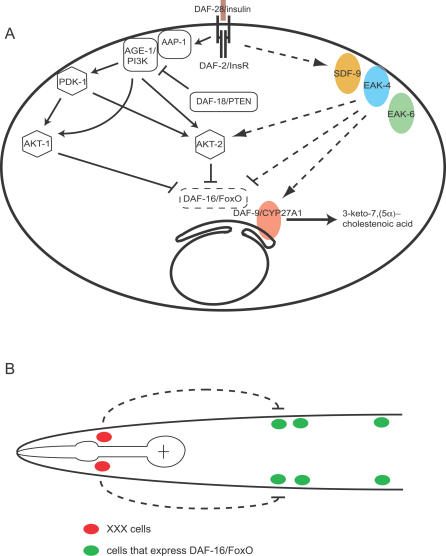
Models of EAK-4, SDF-9, and EAK-6 Function(A) Cell autonomous signaling in XXX. A schematic of one XXX cell is shown. EAK proteins function in parallel with AKT-1 and in the same pathway as AKT-2 to promote nondauer development by potentiating DAF-9/CYP27A1 function either directly or indirectly. DAF-9/CYP27A1 synthesizes 3-keto-7(5α)-cholestenoic acid, a ligand that promotes reproductive development by inhibiting the nuclear hormone receptor DAF-12 [91]. DAF-16/FoxO is denoted with dashed lines, since DAF-16A does not appear to be expressed in XXX. It is not known whether other DAF-16/FoxO isoforms or DAF-2/InsR are expressed in XXX.(B) Nonautonomous signaling from XXX. A schematic of the anterior portion of an animal is shown with the head pointing left. The pharynx is also shown. XXX cells are denoted by red ovals, and DAF-16/FoxO-expressing cells are denoted by green ovals. EAK proteins in the XXX cells generate signals that regulate the synthesis or secretion of a hormone that inhibits DAF-16/FoxO function in other cells.